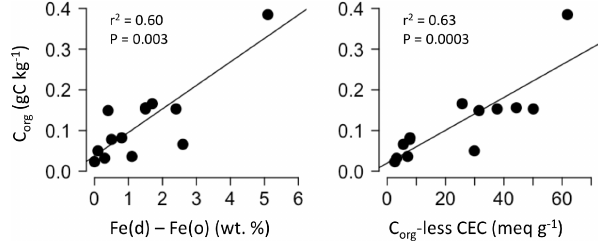
Figure 5. (left) Mean turnover time (TT) of C in the clay-sized XRD fraction increases with smectite concentration; the linear re- lationship for A horizon points ( n = 7) is R-squared = 0.48 and p = 0.08. (right) Mean TT of bulk C averaged for each profile com- pared to the fraction of the total C that is found in the clay-sized fraction ( F clayXRD ). The mean TT of bulk organic C correlates sig- nificantly with the fraction of organic matter strongly associated with the clay-sized XRD fraction. Here, the linear relationship R- squared = 0.54 and p = 0.004.